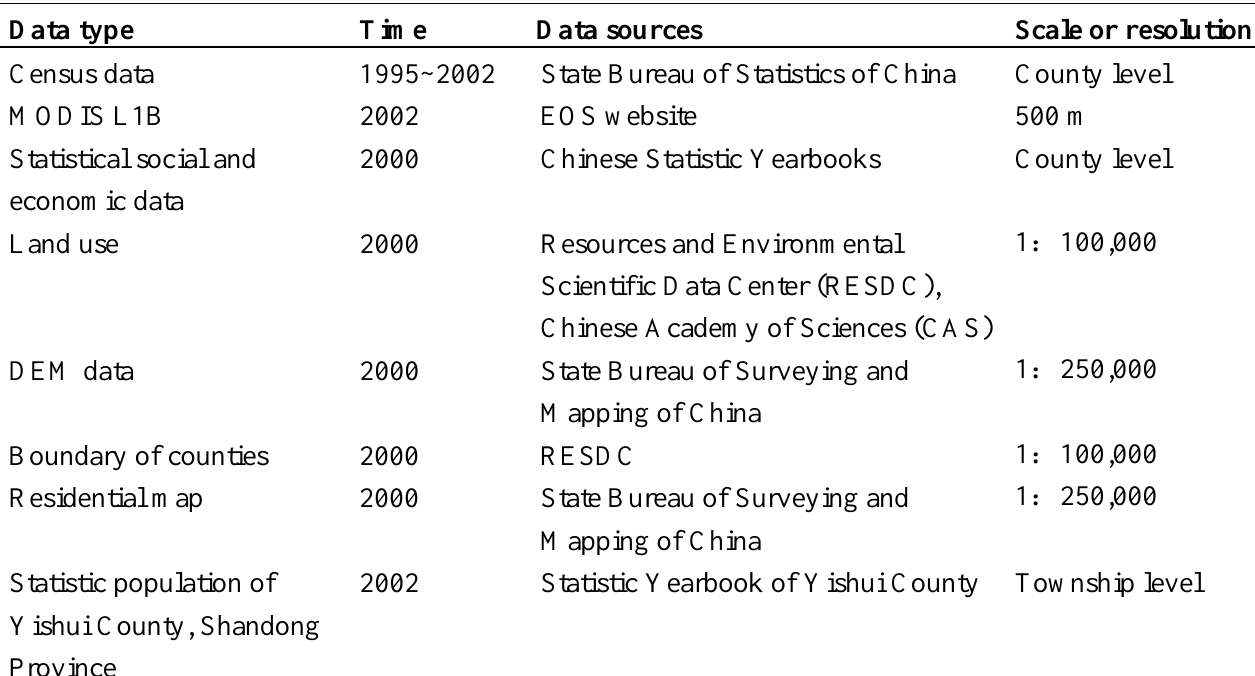
Table 1. List of the Data